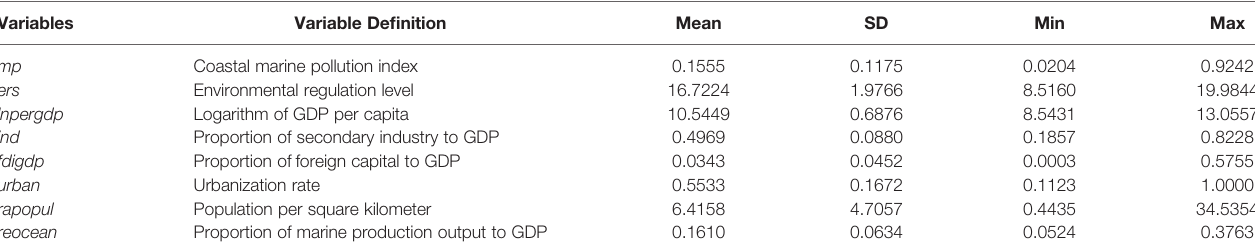
TABLE 1 | Summary statistics.